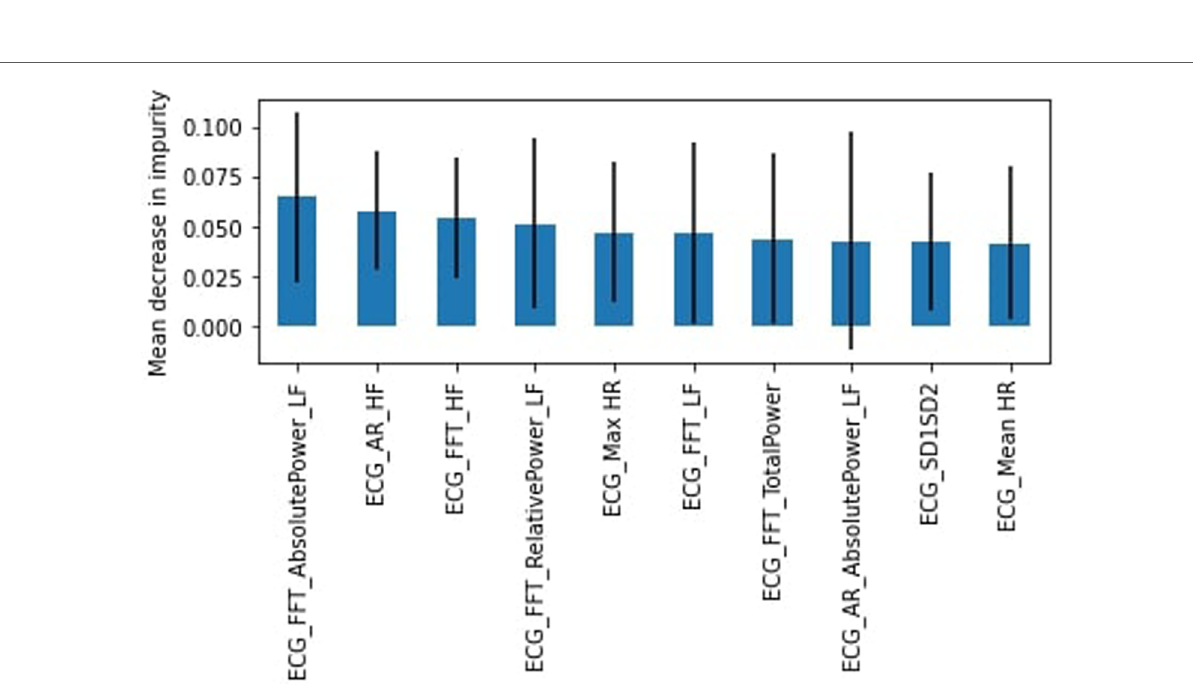
FIGURE 5 RF feature importance, subjects aged 18 –